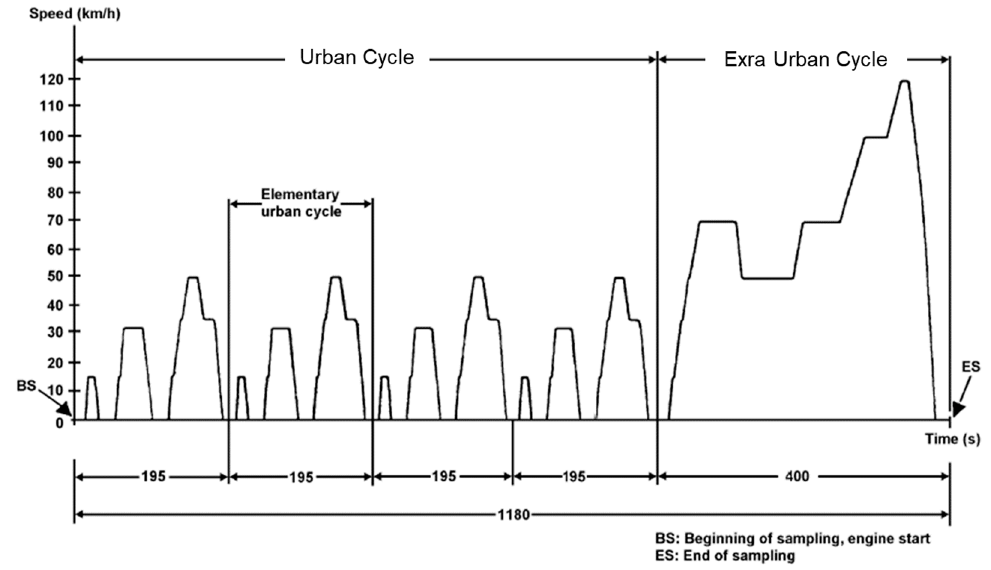
Figure 2. NEDC test cycle